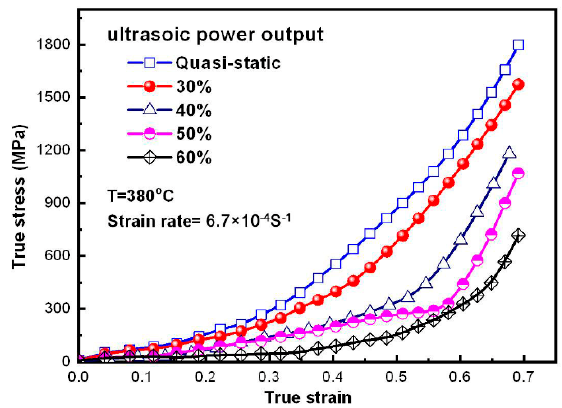
Figure 4. True stress–strain curves for different ultrasonic power outputs.